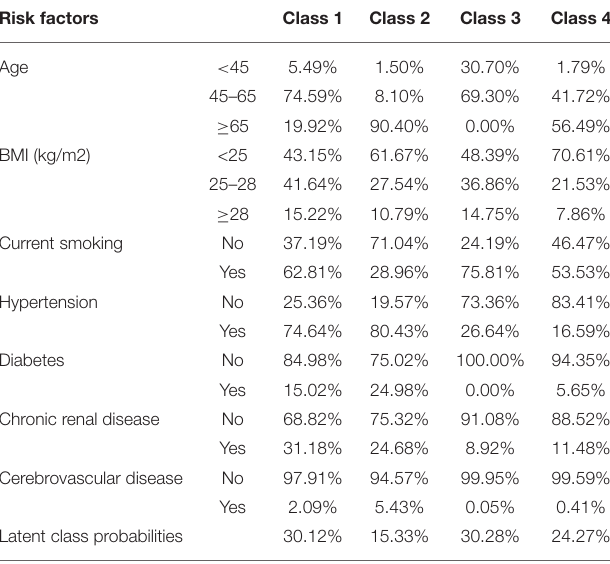
TABLE 2 | Conditional probabilities of patients with risk factor patterns and